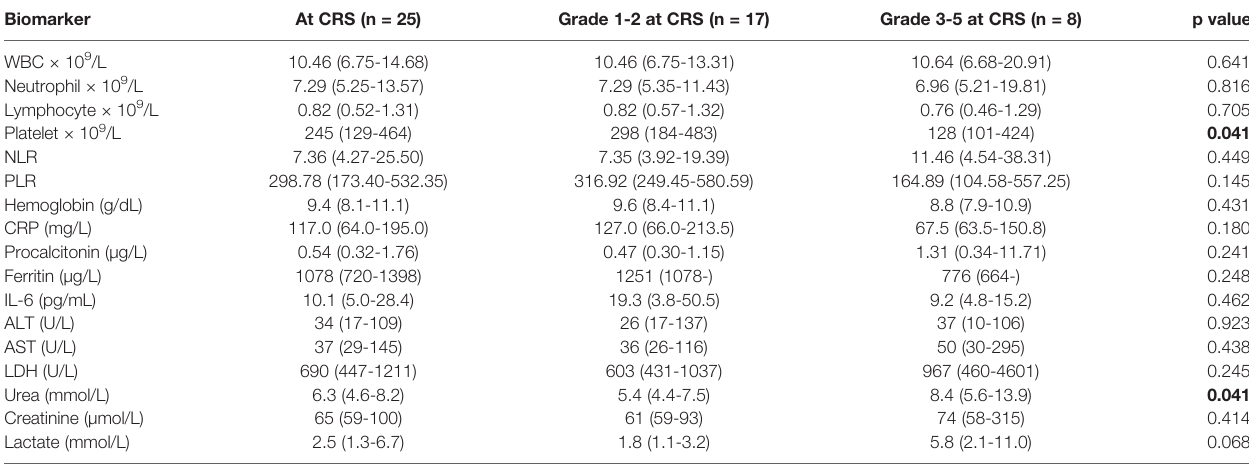
TABLE 3 | Clinical biomarkers related to CRS*. Biomarker At CRS (n =